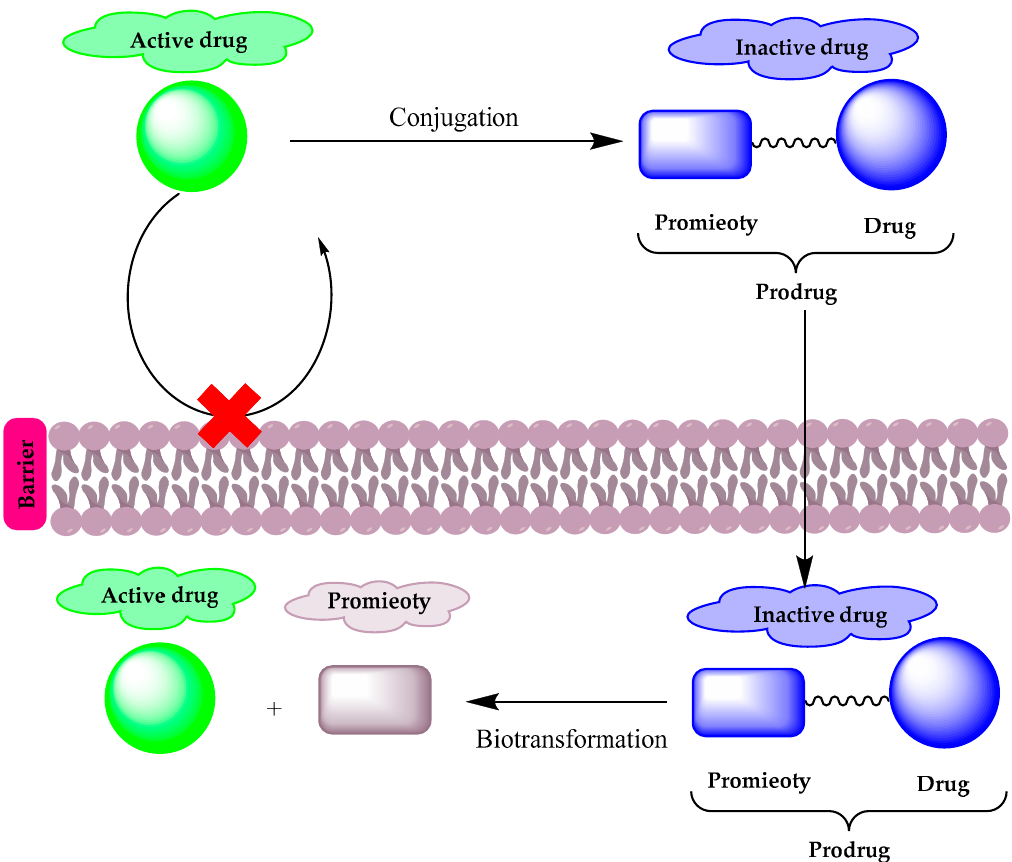
Figure 1. A diagram illustrating the prodrug concept.